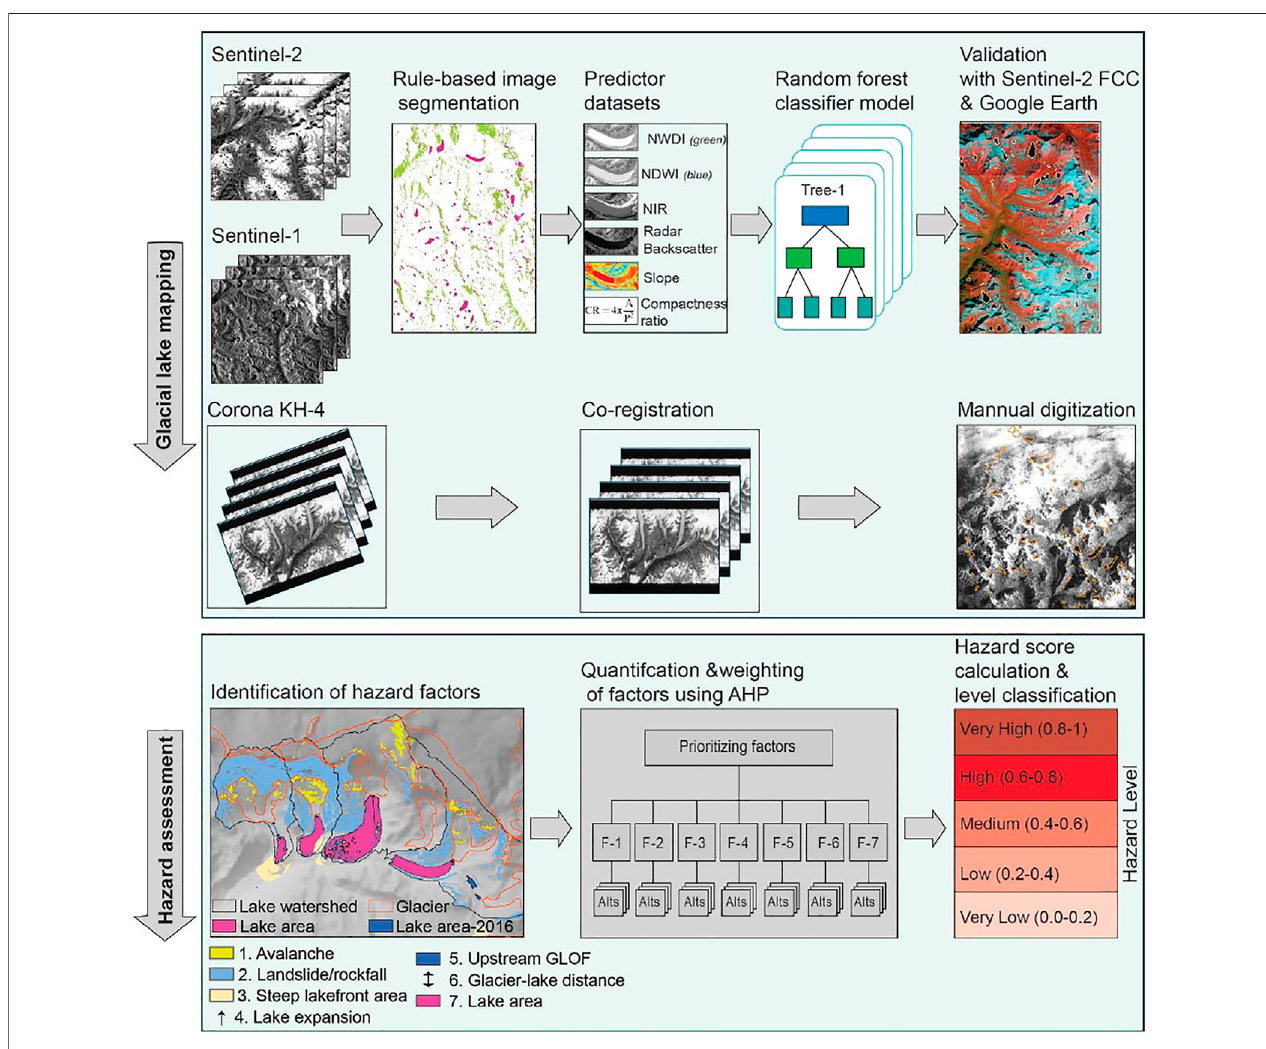
FIGURE 2 | Flowchart of glacial lake mapping and hazard assessment in the Bhutan Himalaya.